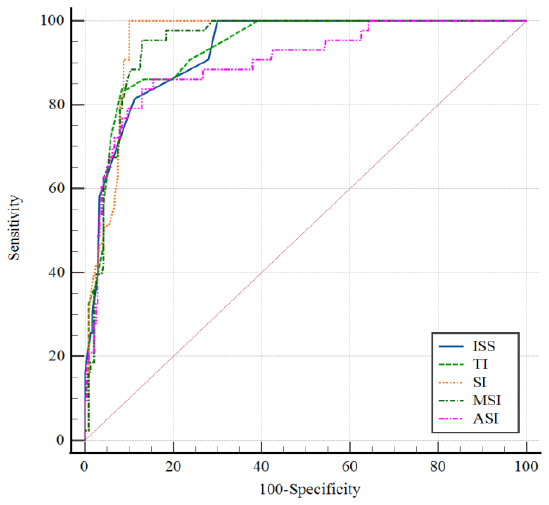
Figure 2. (ROC) curves of different trauma assessment tools for predicting the risk of early mortality in patients. Table 3. The predictive value of different trauma assessment tools on the risk of early mortality in trauma